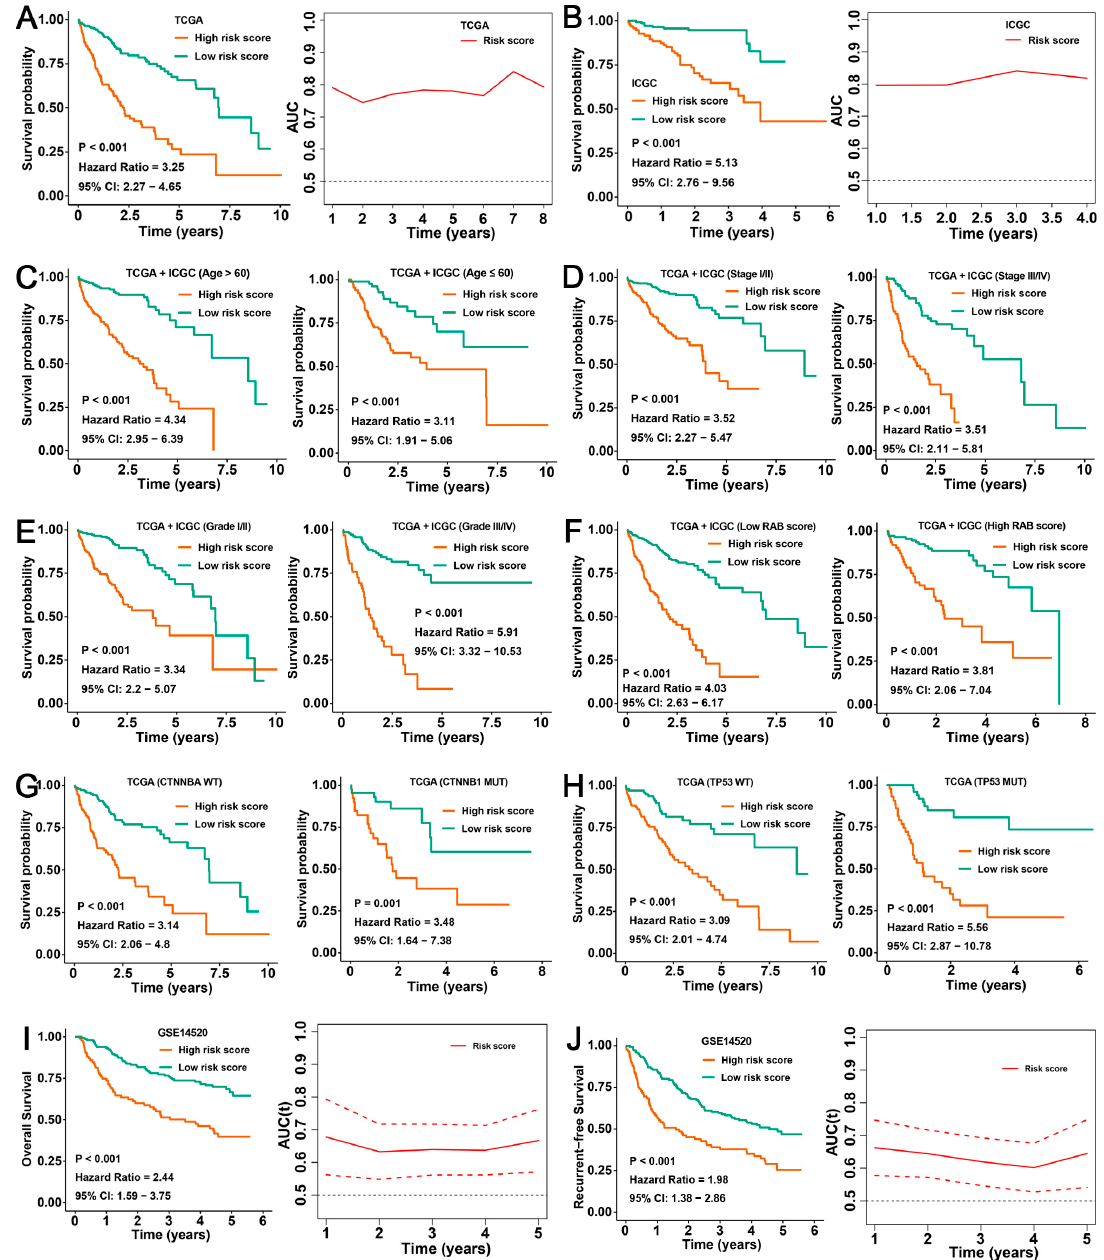
Figure 7. Validation of the RAB risk score for prognostic evaluation in HCC. ( A , B ) Kaplan ‒ Meier curves of OS in patients with HCC from the ( A ) TCGA-LIHC and ( B ) ICGC-LIHC cohorts stratified by the RAB risk score. The time-dependent AUC values of the RAB risk score for the prediction of survival rates (right panel). ( C ) Kaplan ‒ Meier curves of OS in HCC patients with different ages from the pooled HCC cohort stratified by the RAB risk score. ( D ) Kaplan ‒ Meier curves of OS in HCC patients with different tumor stages from the pooled HCC cohort stratified by the RAB risk score. ( E ) Kaplan ‒ Meier curves of OS in HCC patients with different histological grades from the pooled HCC cohort stratified by the RAB risk score. ( F ) Kaplan ‒ Meier curves of OS in HCC patients with different RAB scores from the pooled HCC cohort stratified by the RAB risk score. ( G , H ) Kaplan ‒ Meier curves of OS in HCC patients with different tumor mutation statuses stratified by the RAB risk score. ( I , J ) Kaplan ‒ Meier curves of ( I ) OS and ( J ) RFS in patients with HCC from the GSE14520 cohort stratified by the RAB risk score. The time-dependent AUC values of the RAB risk score for the prediction of survival rates (right